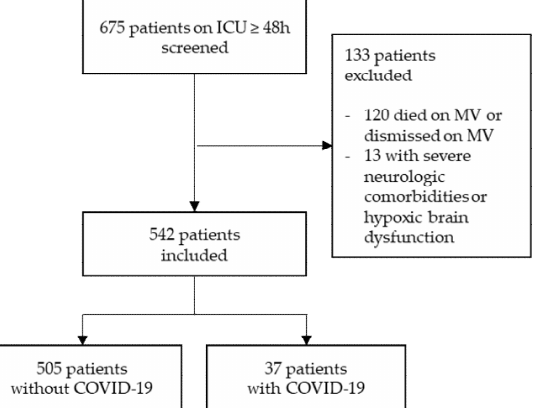
Figure 1. Study population. Flow chart showing patients treated on a medical ICU for at least 48 h that were screened for inclusion. Patients dismissed on invasive mechanical ventilation (MV) without tracheostomy and who therefore could not be evaluated precisely for delirium and patients with severe neurological diseases had to be excluded.